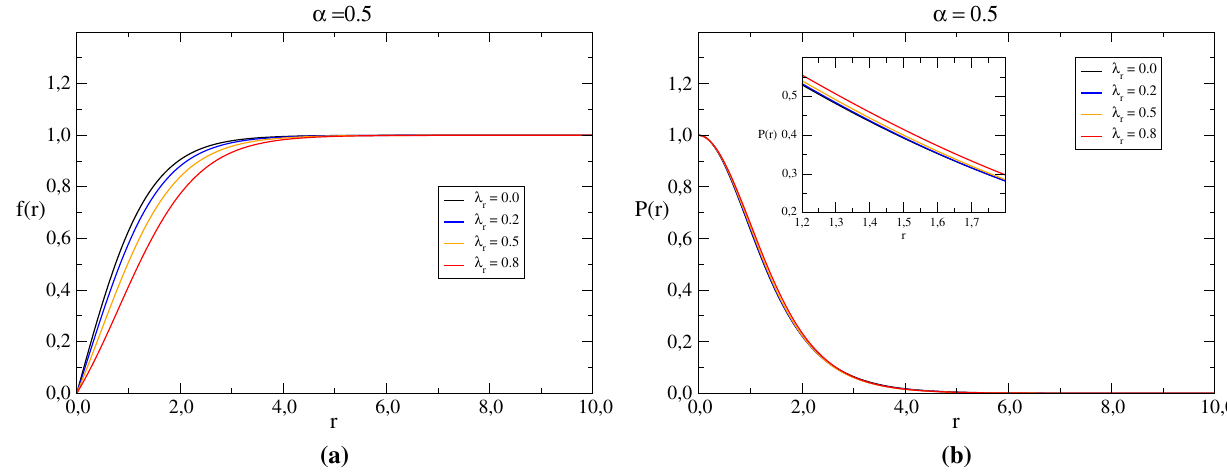
Fig. 2 Intheleftpanel, wepresent thebehavior for theHiggs fieldasafunction of r considering theparameters α = 0 . 5and λ r = 0 . 0 , 0 . 2 , 0 . 5 , 0 . 8. In the right panel we exhibit the gauge field profile for the same α and λ r values